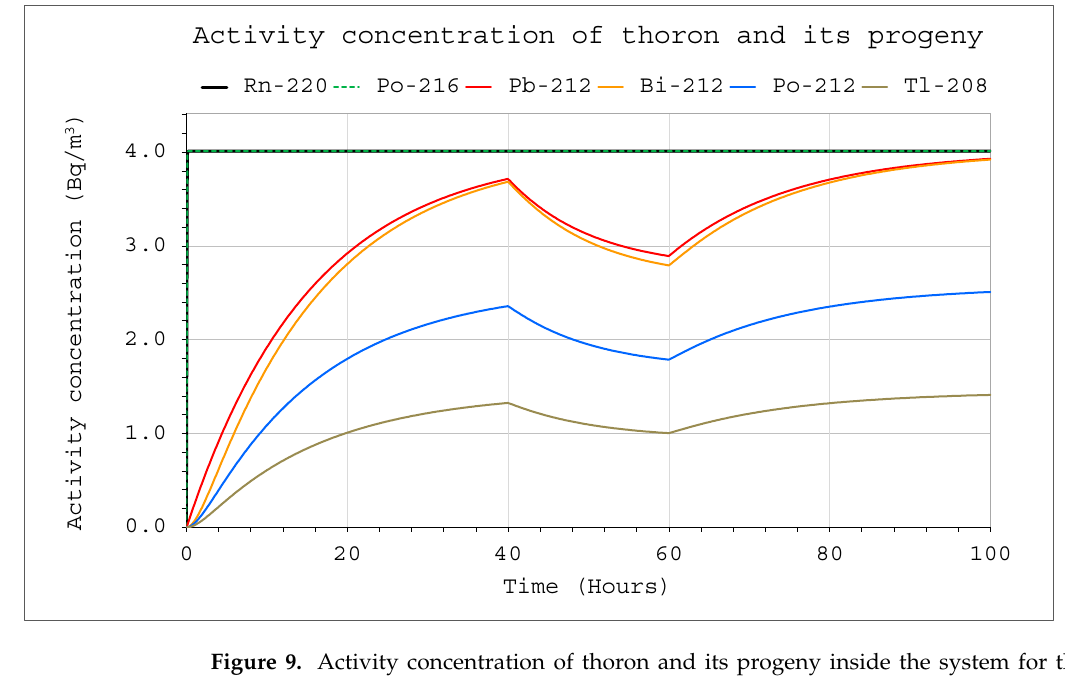
Figure 8. Percentage of the individual thoron progeny in the total PAEC inside the system for the following conditions: inflow of thoron throughout the analyzed period at a rate of E 1 = 1 Bq/s, V = 20 m 3 , C oi = 0. No operating filtration system was operating inside.